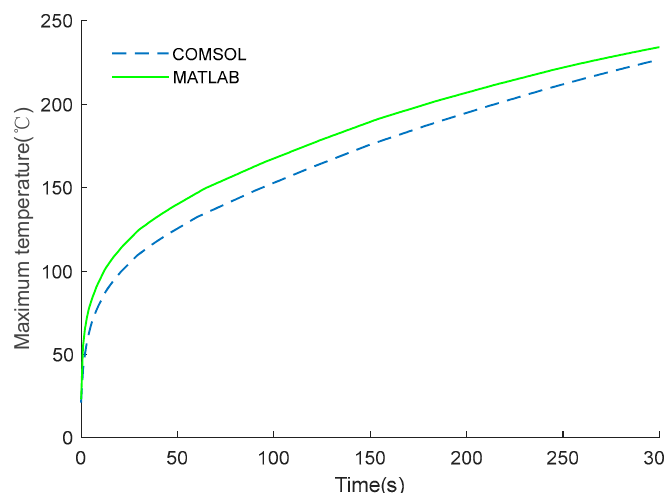
Figure 10. Calculation results under constant voltage excitation.